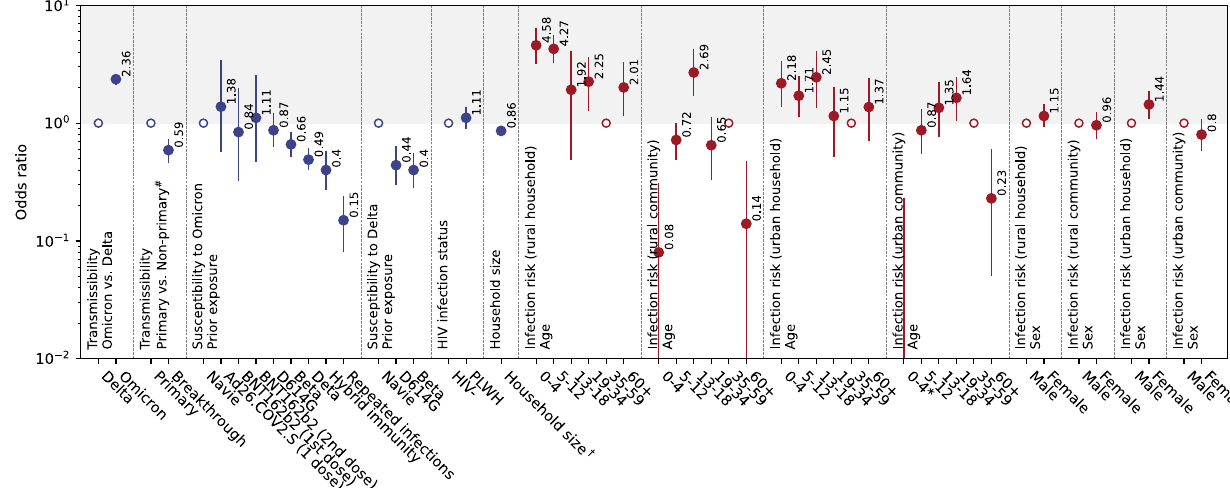
“ Unknown ” for “ HIV infection status ” and category “ Rest ” in “ Prior exposure ” (Table 1) were included in the model but omitted here due to small sample size in the strata. * 0-4 age group have odds ratio point estimate less than 0.01, thus not shown in the fi gure. # Non-primary infections represent repeat/breakthrough infections. † Household size denotes the number of household members within a household and is analyzed as a continuous